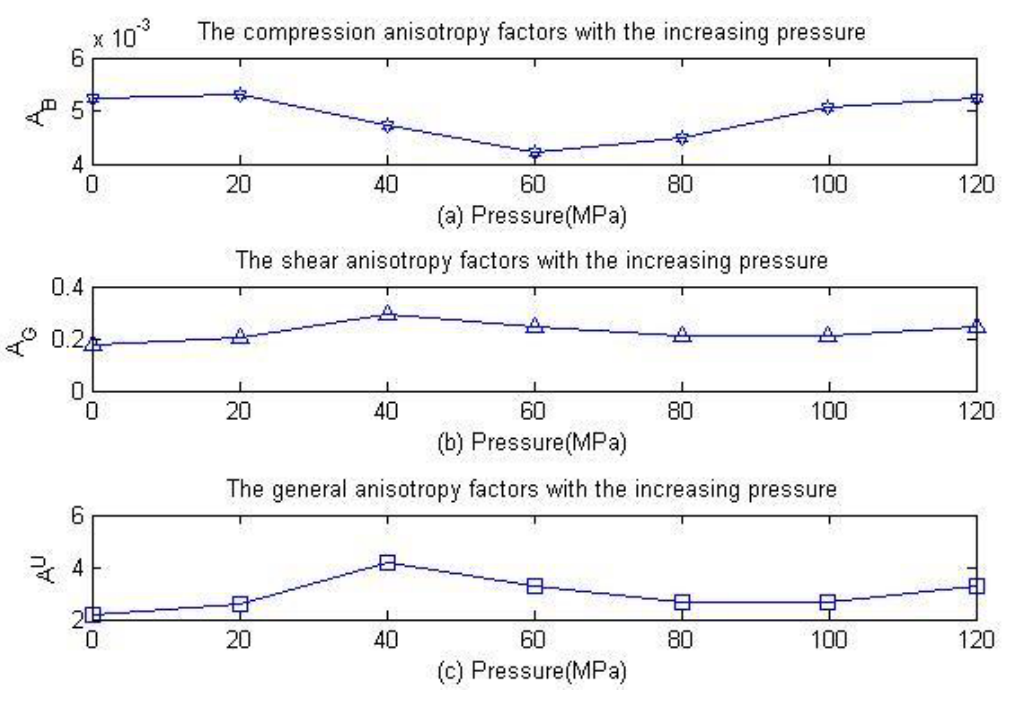
Figure 8. Relationship of the anisotropic percentage of anhydrite crystals with pressure.